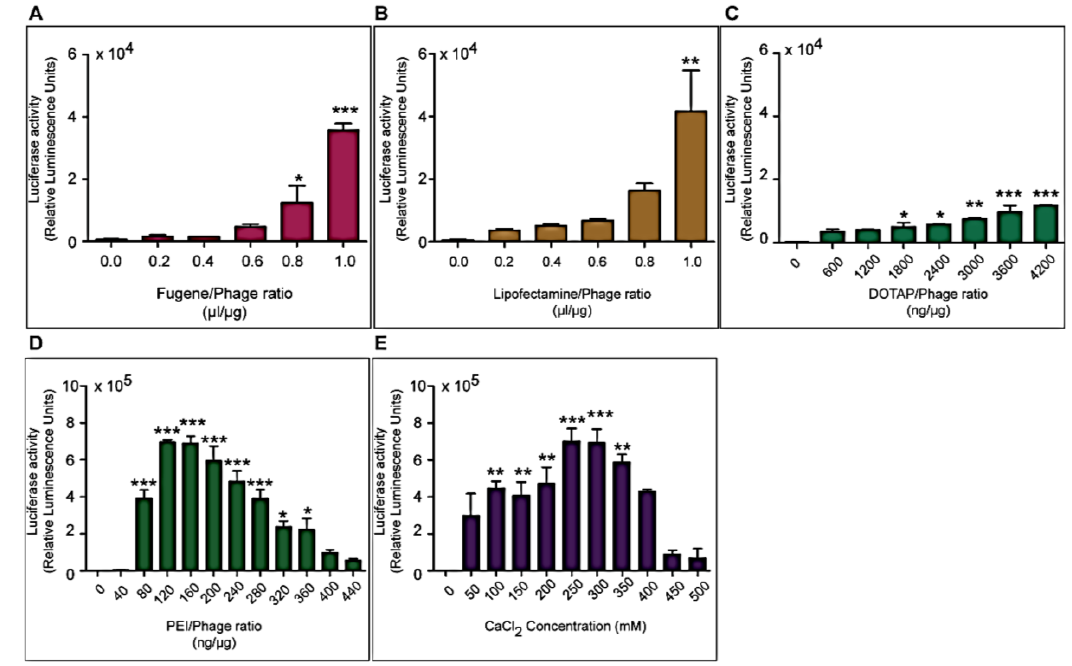
Figure 2. Optimization of transfection reagents for enhanced phage-mediated gene transfer in HEK293 cells. HEK293 cells were treated with phage, carrying the Luc reporter gene, premixed with increasing concentrations of lipid-based reagents ( A . Fugene 6; B . Lipofectamine or C . DOTAP); the cationic polymer PEI ( D ) or calcium phosphate ( E ). Luciferase activity was analyzed at day 3 post-transduction. Results represent the average relative luminescence units of triplicate wells and error bars represent the standard error of the mean. Asterisks are defined as: * p < 0.05, ** p <0.01, *** p < 0.001.